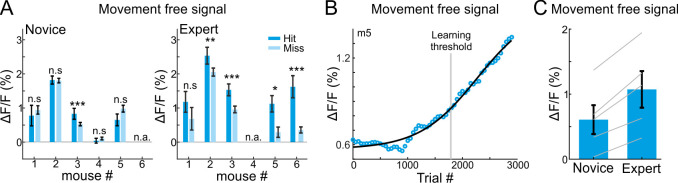
Movement-free MGB choice responses along learning.(A) Mean MGB responses (averaged during stimulus presentation) for movement-free hit and miss trials per mouse during the novice (left) and expert (right) cases (similar to Figure 2C). Error bars are s.e.m across trials. *p<0.05. **p<0.01. ***p<0.001. n.s. – not significant. Wilcoxon rank sum test. (B) MGB response curve for movement-free signals in go trials (averaged during late times, 0.6–1 s after stimulus onset; Similar to Figure 4A) as a function of learning in one example mouse. The data was fitted with a sigmoid function (black line). The learning thresholds is marked with a gray line. (C) Mean MGB responses for movement-free signals in go trials (averaged during late times, 0.2–0.7 s after stimulus onset due to a low number of movement free trails at late times) in novice and expert mice, averaged across all mice (n = 5). Error bars are s.e.m across mice. Gray lines indicate individual mice.